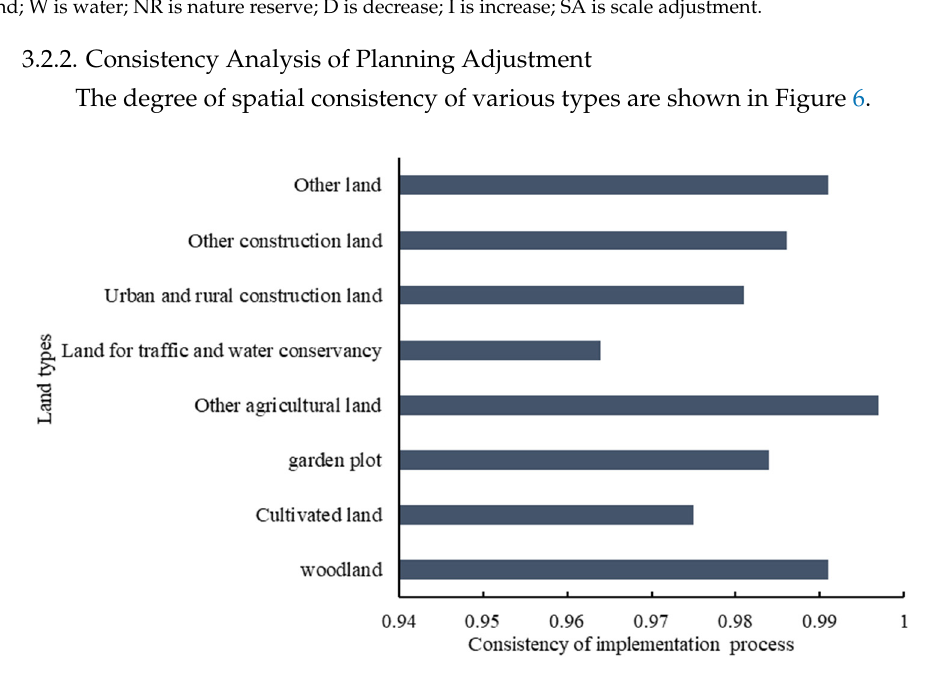
Figure 6. Spatial coincidence degrees and grades of implementation results of regional planning in Rongchang District in 2015.